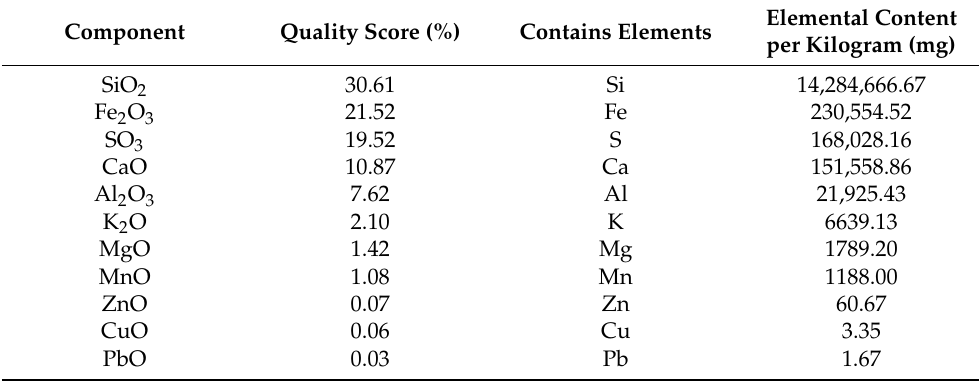
Table 1. Sample tailings XRF analysis and datasheet.